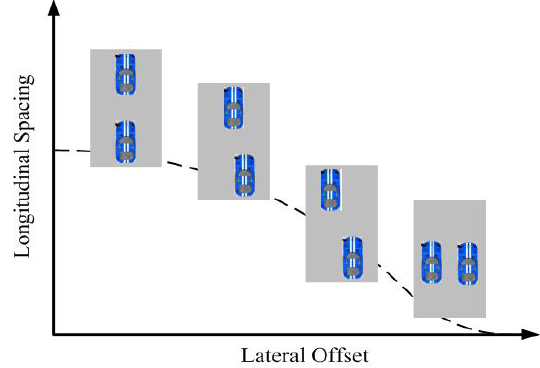
Fig.3. Relationship between horizontal separations of two consecutive vehicles and following distance 13 .